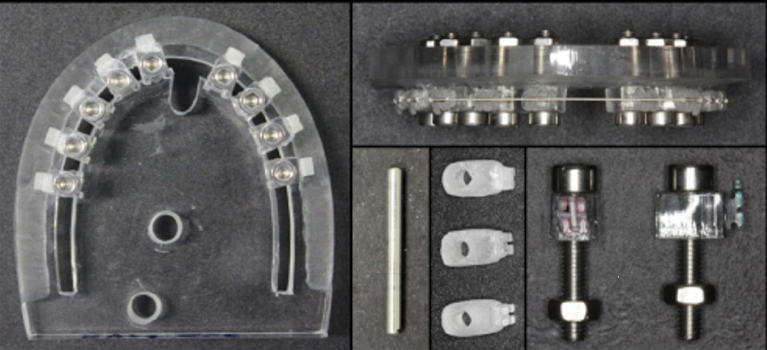
Figure 2- Acrylic resin plate with the structures in position and brackets bonded; acrylic device representative of the right maxillary central incisor and cylindrical metal